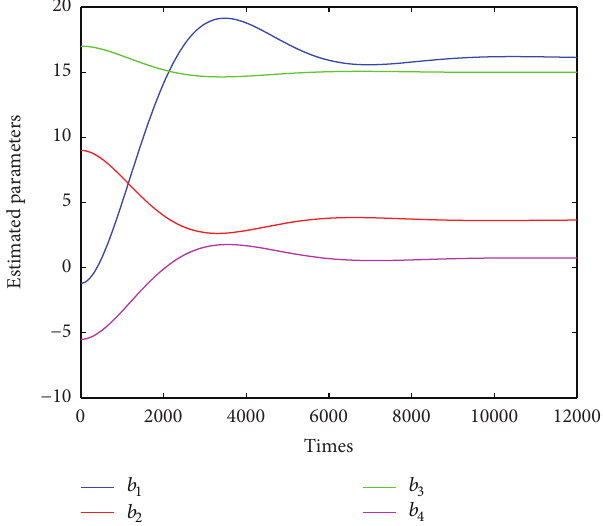
Figure 7: Estimated parameters of memristor chaotic oscillator system